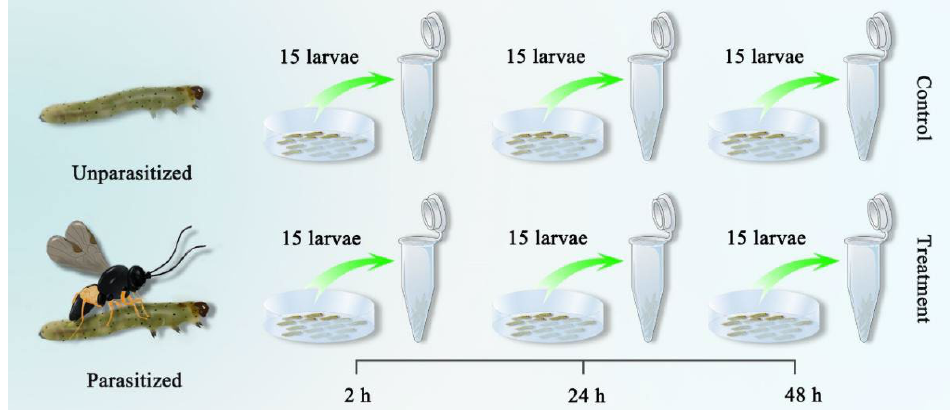
Figure 1. Experimental set-up of transcriptome sequencing. Transcriptome data were generated from the FAW larvae upon 2 h, 24 h, and 48 h parasitization, and the unparasitized larvae at the same developmental stages served as the controls. Three comparisons were performed, including 2 h post-parasitized host vs. 2 h unparasitized host (P2 vs. NP2), 24 h post-parasitized host vs. 24 h unparasitized host (P24 vs. NP24) and 48 h post-parasitized host vs. 48 h unparasitized host (P48 vs. NP48).